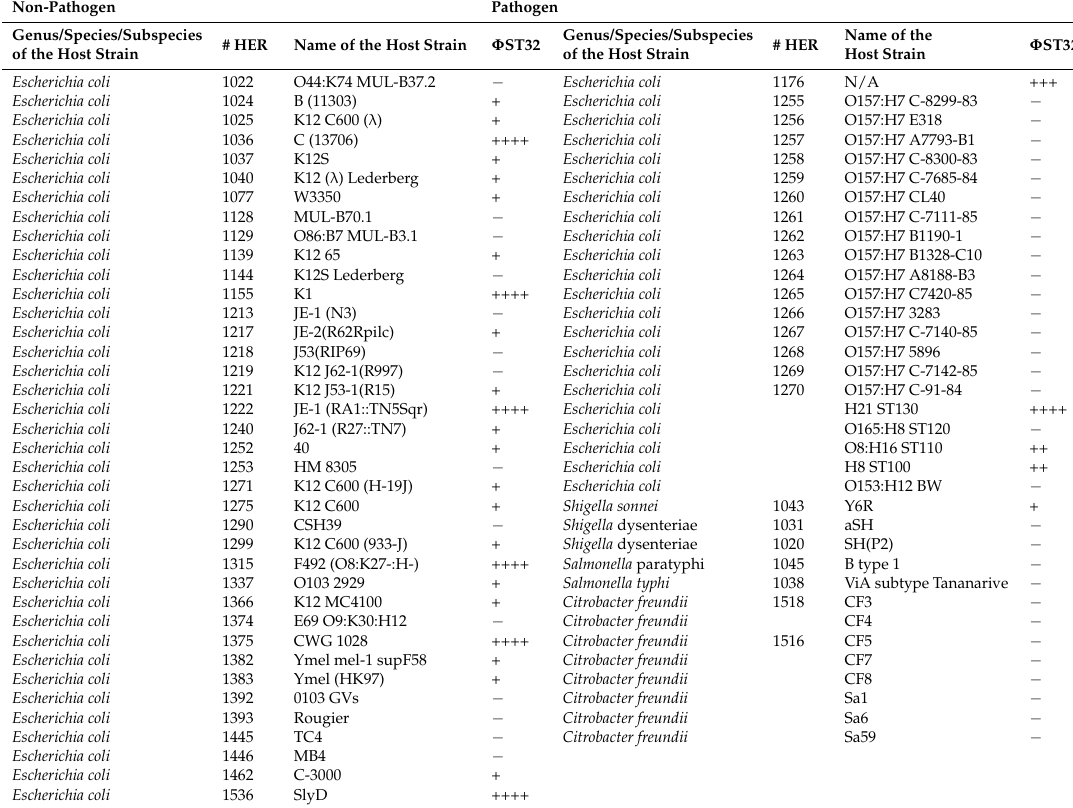
Table 1. The host range of phage